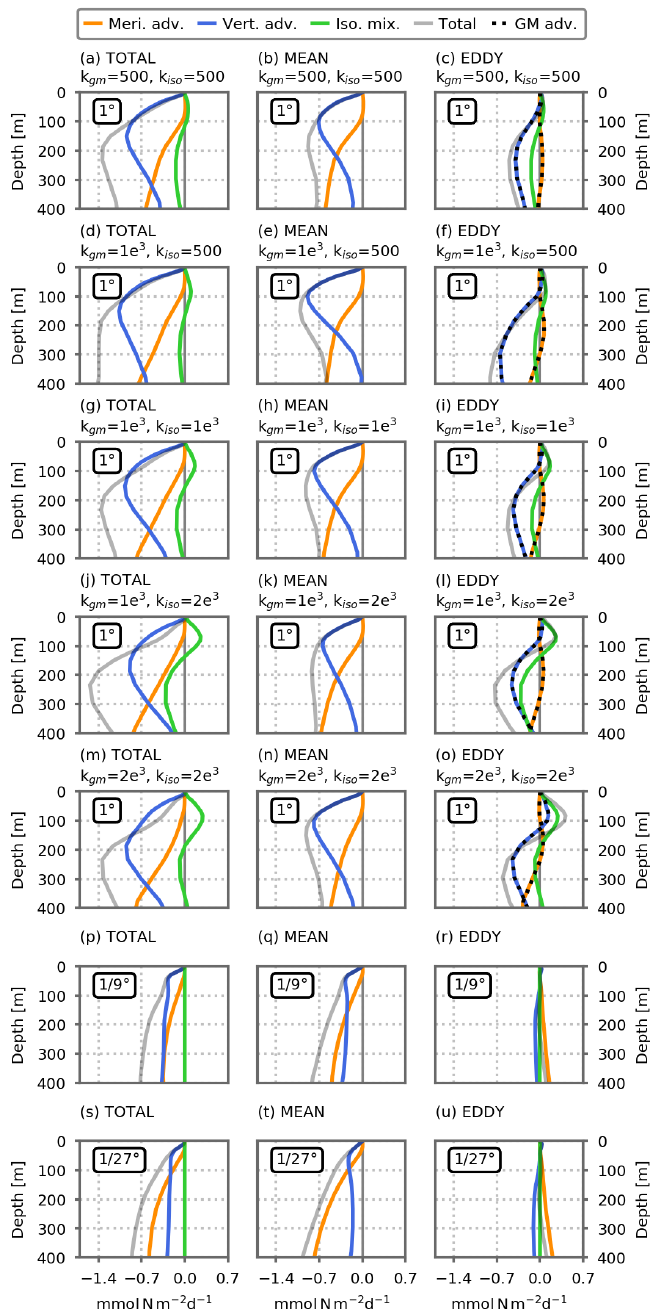
Figure A6. Changes in the dynamical nitrate supplies (mmolNm − 2 d − 1 ) between the climate change and preindustrial control simulations. See Fig. A5 for details. The change is relative to the preindustrial control simulations. Positive values indicate an increase in nitrate input either because an inflow increases or because an outflow